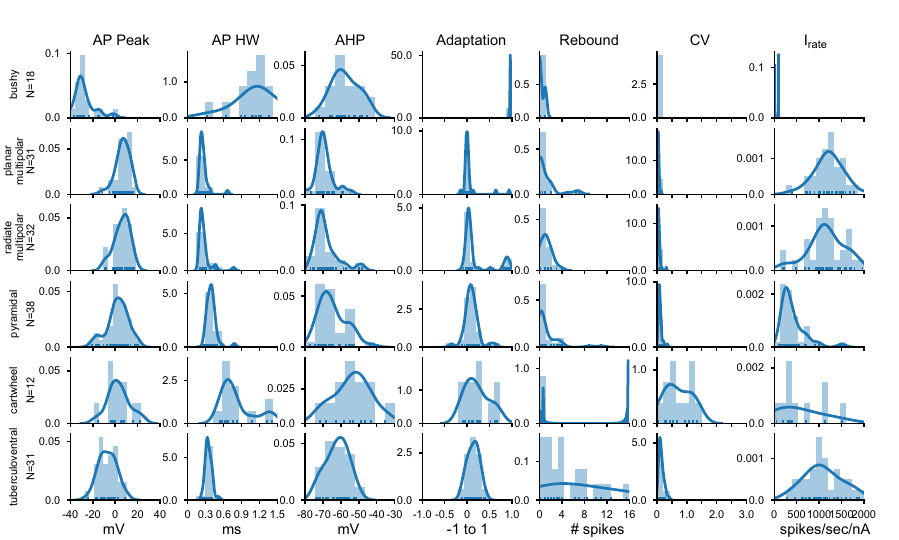
Fig 3. Summary of action potential shape and firing patterns across the population of CN neurons. AP Peak: action potential peak potential; APHW: action potential half-width; AHP: action potential afterhyperpolarization; Adaptation: adaptation calculated from the response to a suprathreshold current injection; Rebound: count of rebound action potential after the end of the hyperpolarizing current injection; CV: coefficient of variation of interspike intervals; I rate : slope of the current-firing relationship for current levels just above spike threshold. The ordinate indicates the population density based on the kernel density estimate (blue line). The histograms show the distribution of values from the population cells for each type and